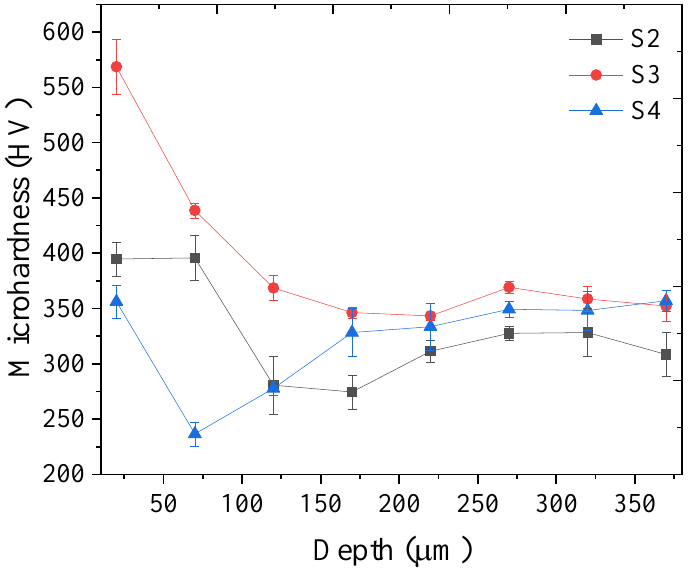
Figure 5. Microhardness along the cross-section of NiTi alloy after laser nitriding. Since the body implants made of NiTi alloy have to be replaced after their service life due to their wear and abrasion, it is important to enhance and improve their surface wear and abrasion resistance. The wear property of NiTi is measured before and after laser nitriding treatment to study the effect of laser nitriding on the wear resistance of NiTi alloy. The coefficient of fiction of NiTi alloy can be used to represent its wear property during wear testing. Figure 6 presents the relationship between the coefficient of friction and wear time on the NiTi alloy with different laser nitriding treatment. It can be seen that the coefficient of friction of sample S-4 treated by laser nitriding with a scanning speed of 40 mm/s and frequency of 200 kHz at low temperature is similar to that of untreated NiTi alloy sample with a friction coefficient of 0.74. The reason for the results is that the thickness of the melted layer is very thin. The friction coefficient of sample S-2 treated by laser nitriding with a scanning speed of 80 mm/s and frequency of 100 kHz was lower than that of the untreated sample and increased gradually to around 0.74 at the fretting time of 100 s. The friction coefficient of sample S-3 treated by laser nitriding with 40 mm/s and 200 kHz at room temperature increased from 0.20 to 0.40 at the fretting time of 50 s and became stable with a friction coefficient of 0.4 after a fretting time of 50 s. As can be seen, the friction coefficient of NiTi alloy (S-3) treated with 40 mm/s and 200 kHz at room temperature is significantly lower compared to other samples. The lower friction